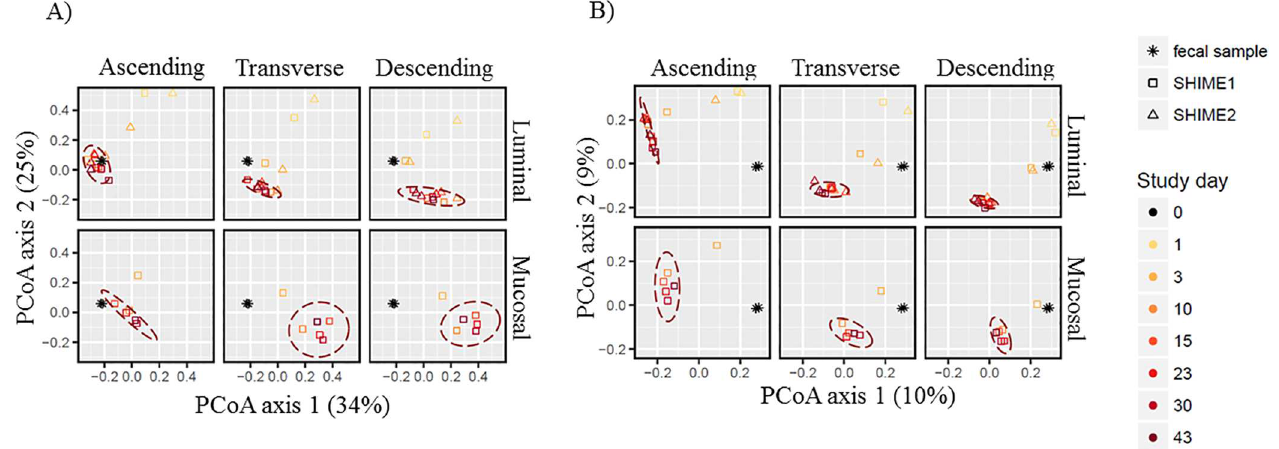
Fig 1. PCoA plot based on UniFrac distances of the gut microbial communities established in the luminal and mucosal phases for the ascending, transverse and descending regions over time. After calculating the axes, the samples are faceted into their corresponding regions. The dashed ellipses represent samples in that facet 3 days after inoculation that fall within a 95% confidence interval. (A) Weighted UniFrac distance analysis, (B) Unweighted UniFrac distance analysis.